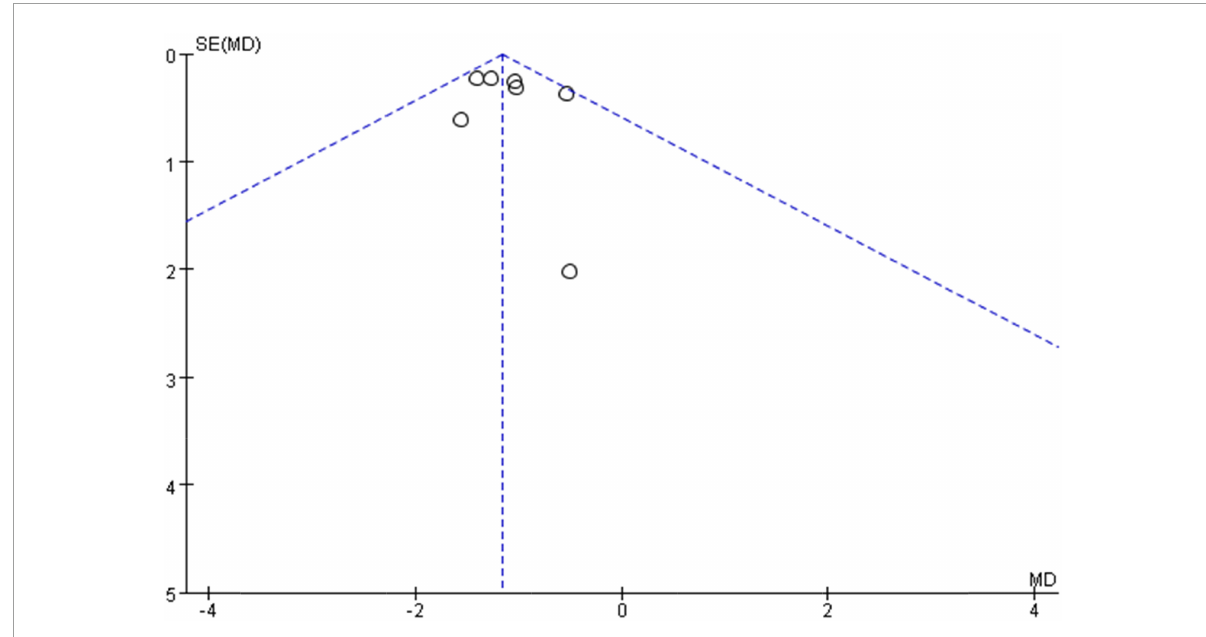
FIGURE6 Funnel plots (VAS) after removing two biased studies after sensitivity